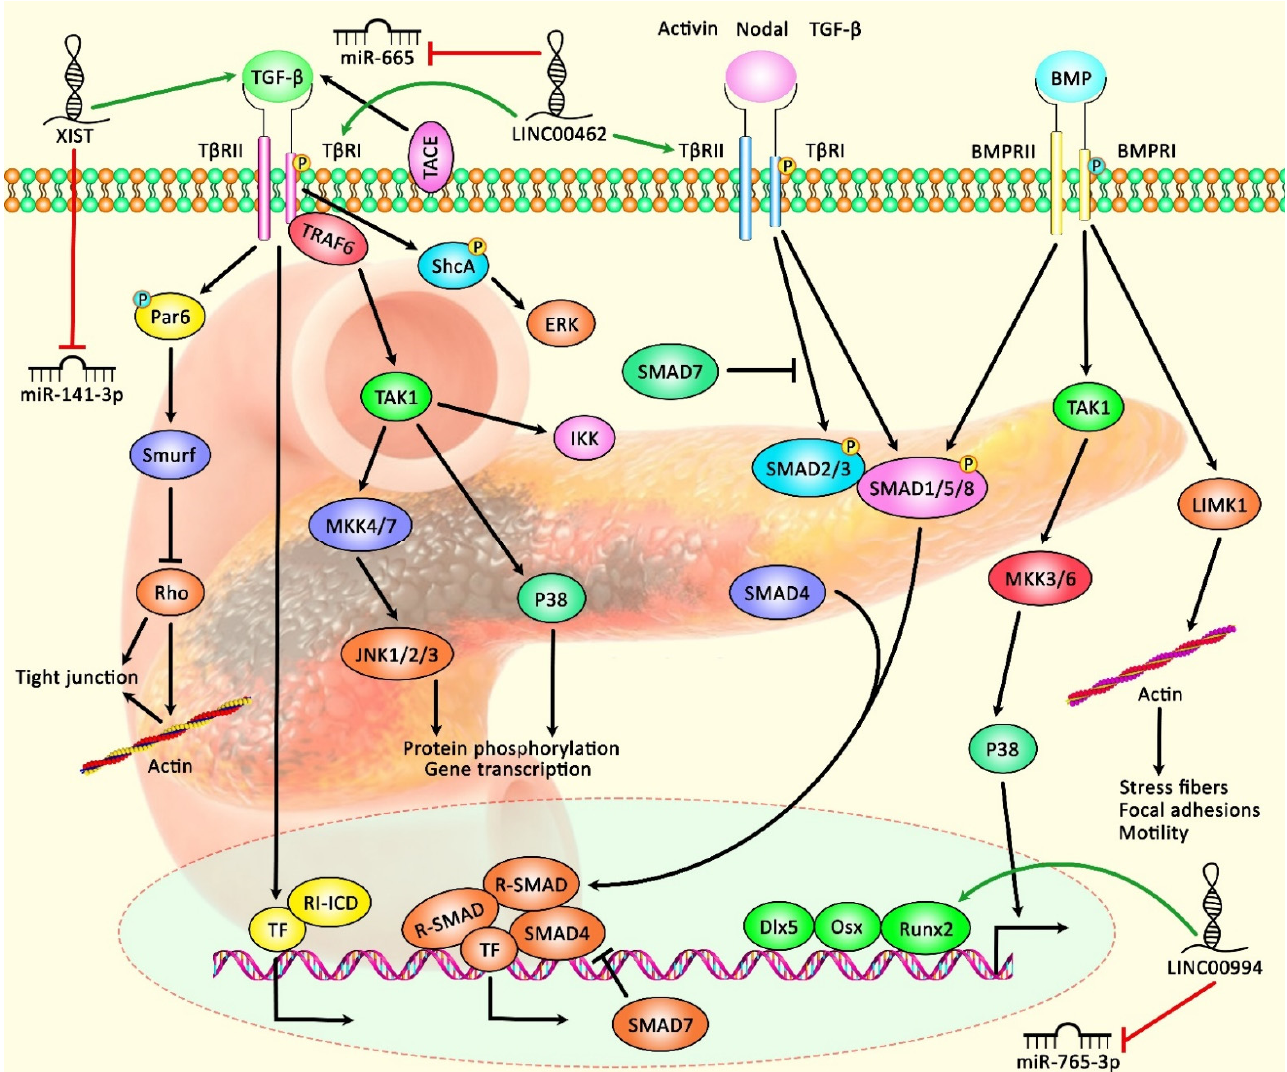
Figure 1. A schematic diagram shows the role of various lncRNAs in modulating the TGF- β /SMAD signaling pathway in pancreatic cancer. According to this cascade, when bioavailable TGF- β binds a homodimer of T β RII, transphosphorylation of the T β RI can trigger the activation of kinase activity. SMAD proteins, the substrates for T β RI kinases, are downstream of the BMP–analogous ligand–receptor systems. SMAD1, SMAD2, SMAD3, SMAD5, and SMAD8 can bind to membrane- bound serine/threonine receptors and are up-regulated via their kinase function. As a co-factor, the Co-SMAD (SMAD4) can bind to the up-regulated R-SMAD to create a complex that translocates into the nucleus. Consequently, I-SMAD (SMAD7) can deactivate the impacts of R-SMADs [36,37]. Previous studies have authenticated that several lncRNAs can play an effective role in regulating the TGF- β /SMAD cascade in pancreatic cancer. LINC00462 can up-regulate expression levels of TGFBR1 and TGFBR2 and activate the SMAD2/3 pathway in pancreatic cancer cells through down-regulating miR-665 expression [8]. Furthermore, lncRNA XIST can promote TGF- β 2 expression via inhibiting the expression of miR- 141-3p, thus enhancing cell proliferation, migration, and invasion of PC cells [33]. Green arrows indicate the up-regulation of target genes by lncRNAs; red arrows depict the inhibitory effects of lncRNAs.